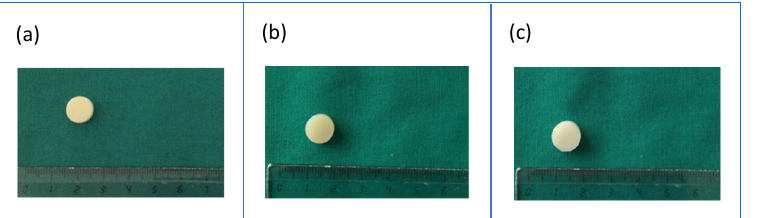
Figure 1. The test discs obtained from each orthodontic composite resin: ( a ) Light-Cure Orthodontic Paste (Light); ( b ) Transbond XT TM Light Cure Adhesive (Trans); ( c ) Bisco Ortho Bracket Paste LC (Bisco).